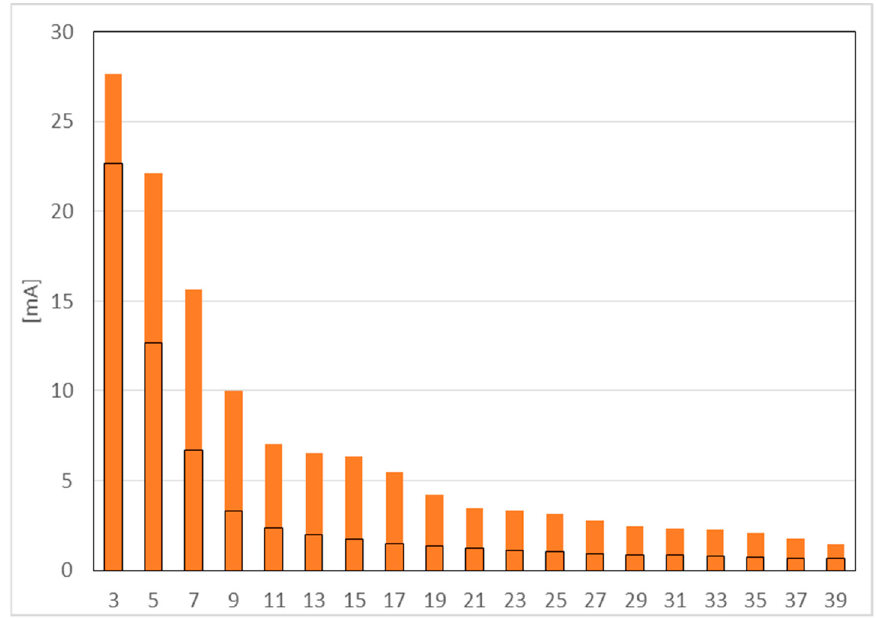
Figure 8. Harmonic emissions test.